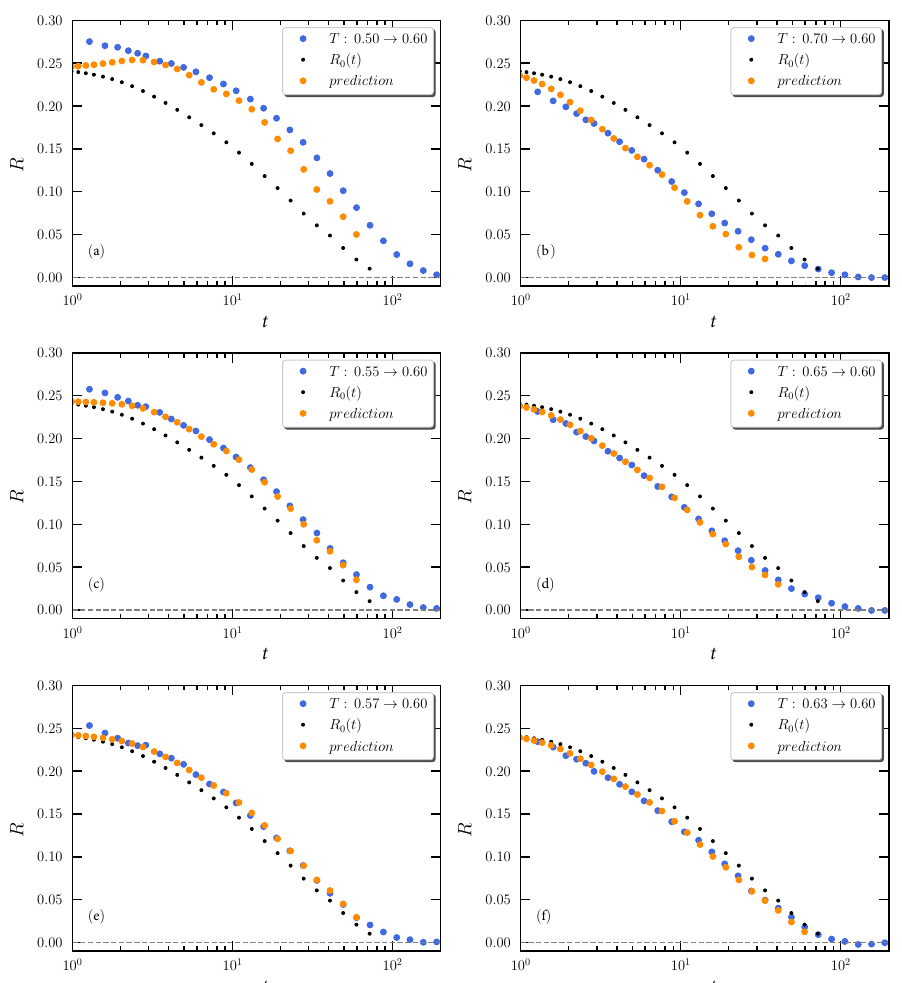
Figure 1. Results from computer simulations of the Kob–Andersen binary Lennard–Jones model. The figures show the normalized relaxation function R ( t ) (Equations (25) and (29)) defined from the potential energy U after a temperature jump at t = 0 starting from a state of thermal equilibrium (blue filled circles): ( a , b ) show results for magnitude 0.10 temperature up and down jumps to the reference temperature T 0 = 0.60; ( c , d ) show results for magnitude 0.05 temperature up and down jumps to T 0 = 0.60; ( e , f ) show results for magnitude 0.03 temperature up and down jumps to T 0 = 0.60. The orange filled circles are the first-order predictions of the jump differential equation Equation (9) (given in Equation (25) in which R 0 ( t ) is the normalized equilibrium potential-energy time-autocorrelation function at T 0 = 0.60, R 1 ( t ) is given by Equation (29), and Λ is given by Equation (39)). For reference, in all figures R 0 ( t ) is plotted as small black filled circles. The averages were smoothed using a Gaussian function. Each point represents an average cal- ( t ( ( t R ( t (cid:48) ) exp ( t (cid:48) ) 2 / σ ) / ∑ t (cid:48) ) 2 / σ culatedoverallthedatapointsusing R avg ( t ) = ∑ t t (cid:48) exp − − − − (cid:48)